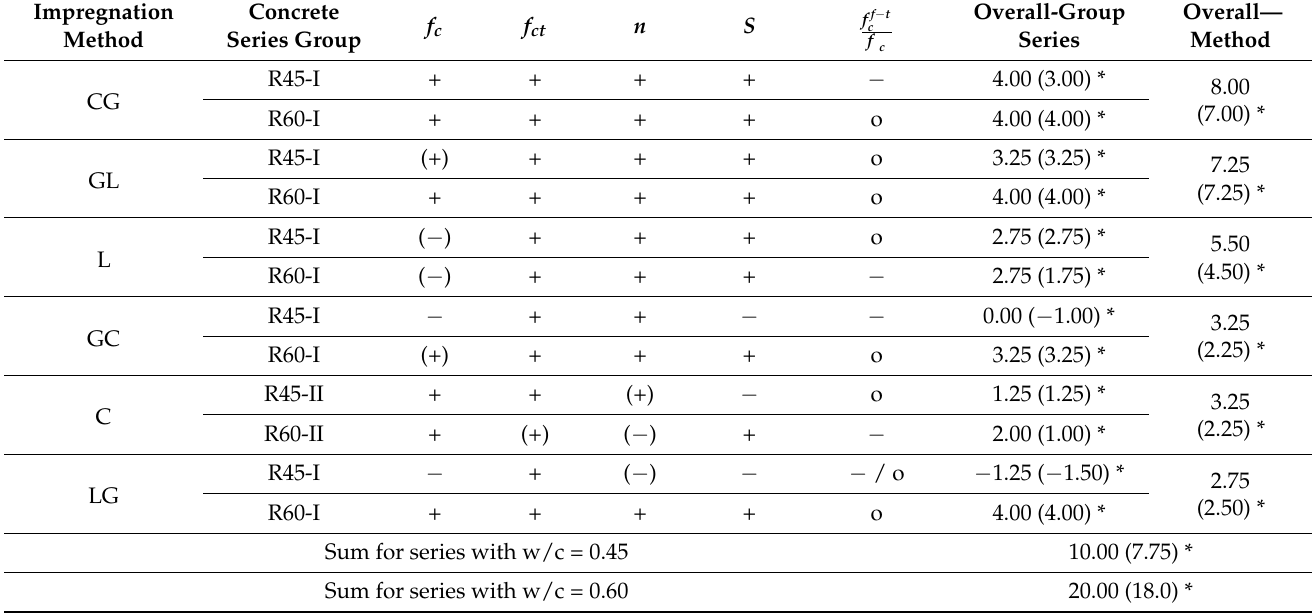
Table 7. Simplified qualitative evaluation of the effectiveness of impregnation methods.